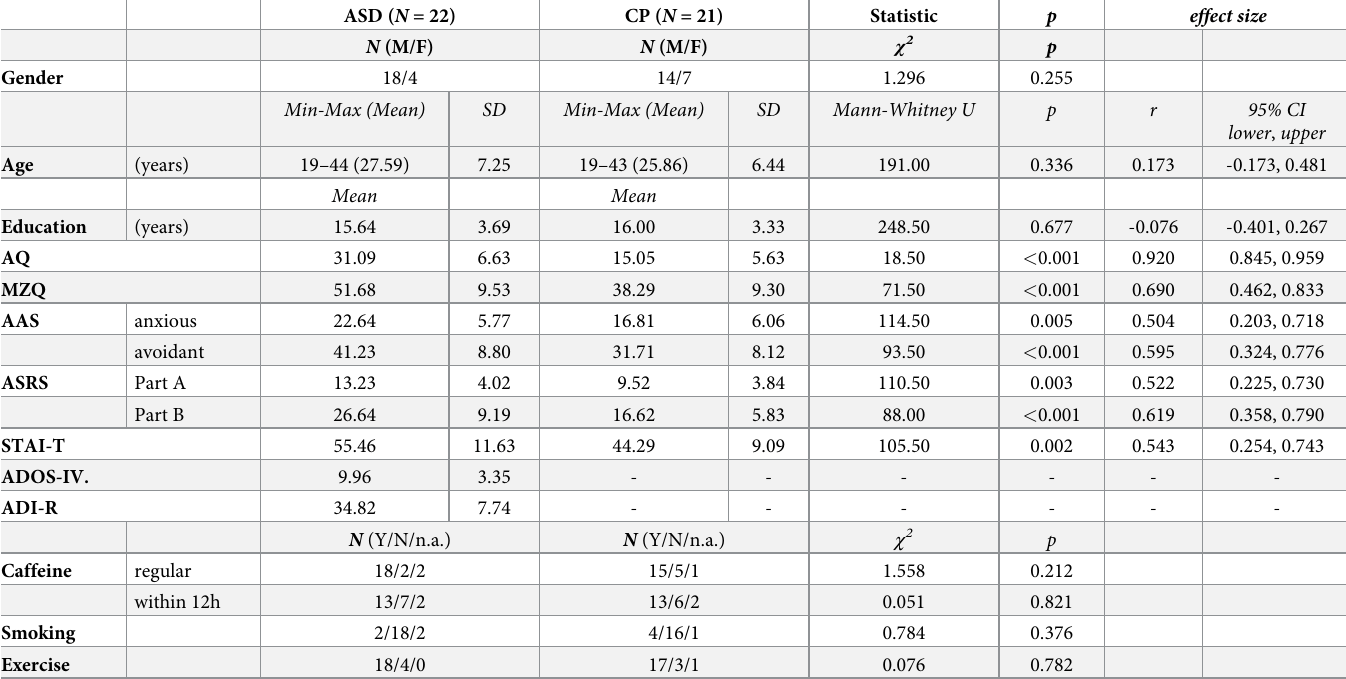
Table 1. Demographics and clinical